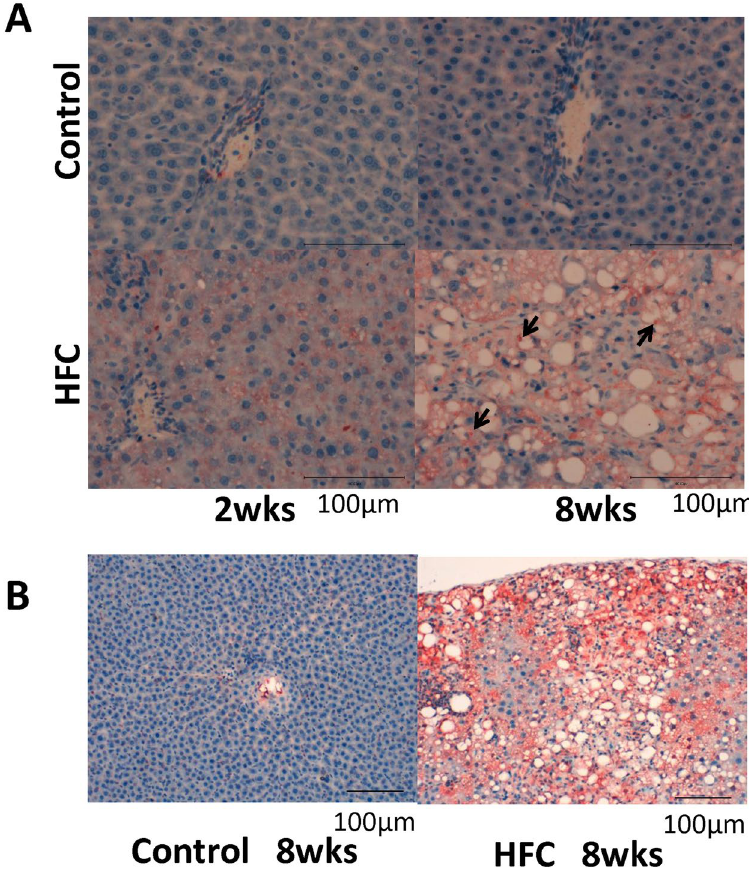
Figure 1. ( A ) Representative images of p62 immunostaining of samples from SHRSP5/Dmcr rats fed control and HFC diets for 2 and 8 weeks. Arrows indicate the accumulation in the cytoplasm of enlarged hepatocytes. Scale bar 100 μ m. ( B ) Representative images of ubiquitin immunostaining of samples from rats fed control and HFC diets for 8 weeks. Scale bar 100 μ